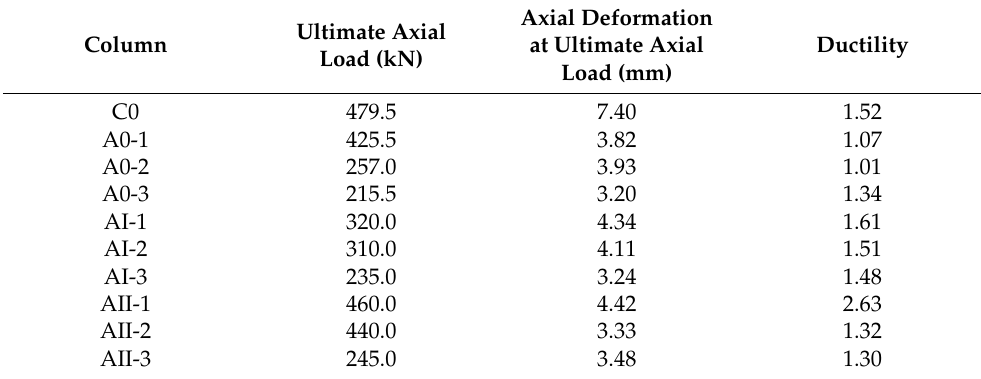
Figure 9. Axial load–axial deformation responses of column specimens. ( a ) Unloaded specimens with different corrosion degrees, ( b ) Specimens subjected to 30% ultimate load and various corrosion degrees, ( c ) Specimens subjected 60% ultimate load and various corrosion degrees, ( d ) Specimens subjected 16-days accelerated corrosion and various sustained load, ( e ) Specimens subjected to 31-days accelerated corrosion and various sustained load, ( f ) Specimens subjected to 63-days accelerated corrosion and various sustained load. Table 3. Experimental results of column specimens.